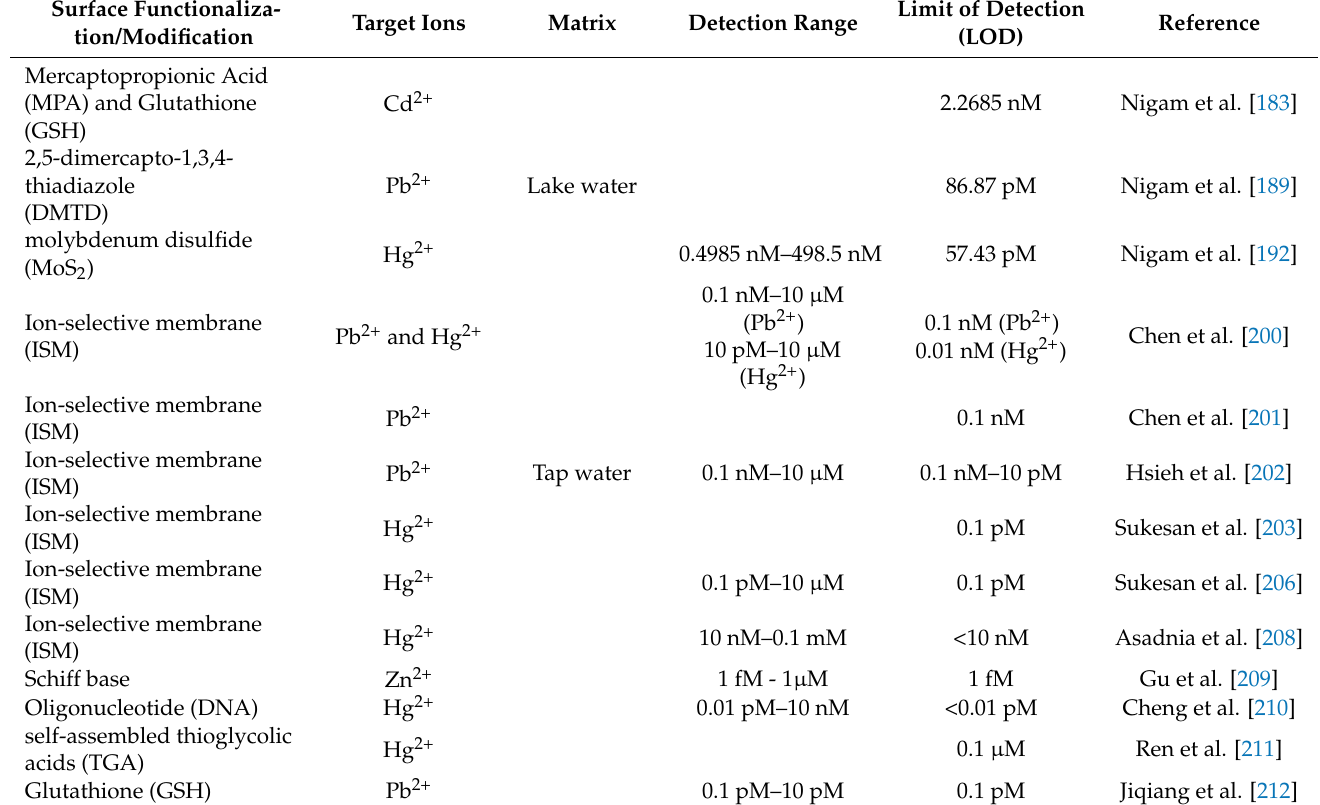
Table 5. AlGaN/GaN HEMT applications in relation to electrical detection used for heavy metals detection. Surface Functionaliza-